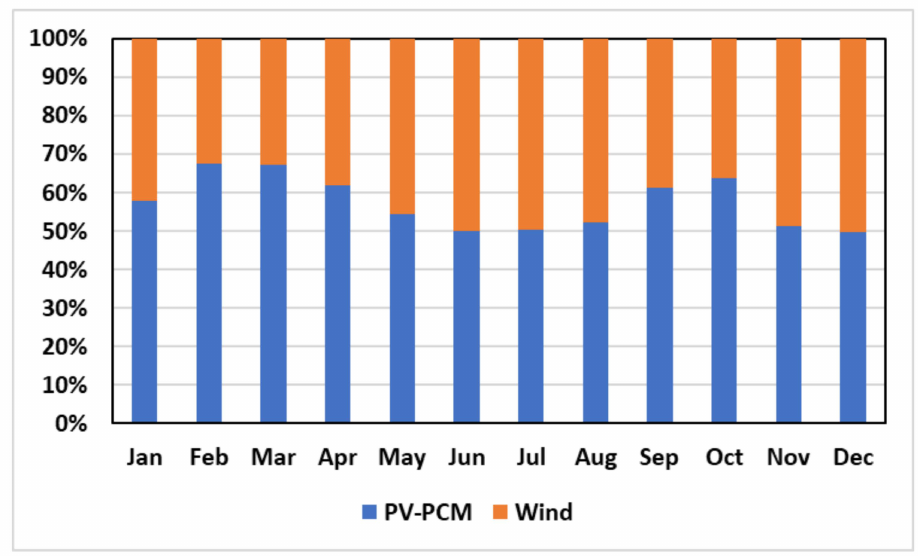
Figure 8. Monthly energy contribution of Conf-2.